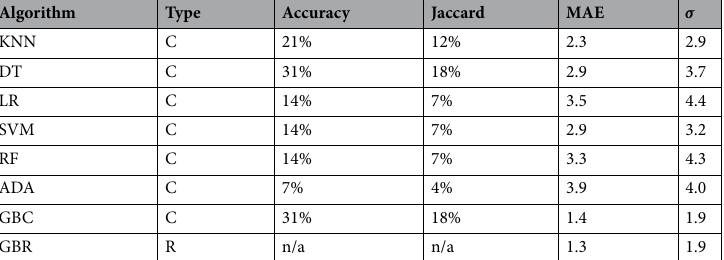
Table 8. Machine learning for hardness prediction. Out-of-sample accuracy and Jaccard index for different machine learning algorithms. The MAE (GPa) and standard deviation σ (GPa) consider the entire dataset. Classification algorithms (C) target the best calculation relation, and the regression algorithms (R) the hardness value directly.